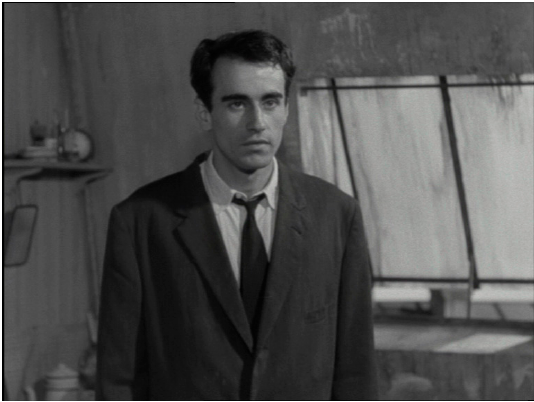
Figure 2. Suggestion by restraint: Martin Lasalle’s acting seldom offers obvious clues to Michel’s state of mind. Source Artificial Eye: ART 295 DVD.